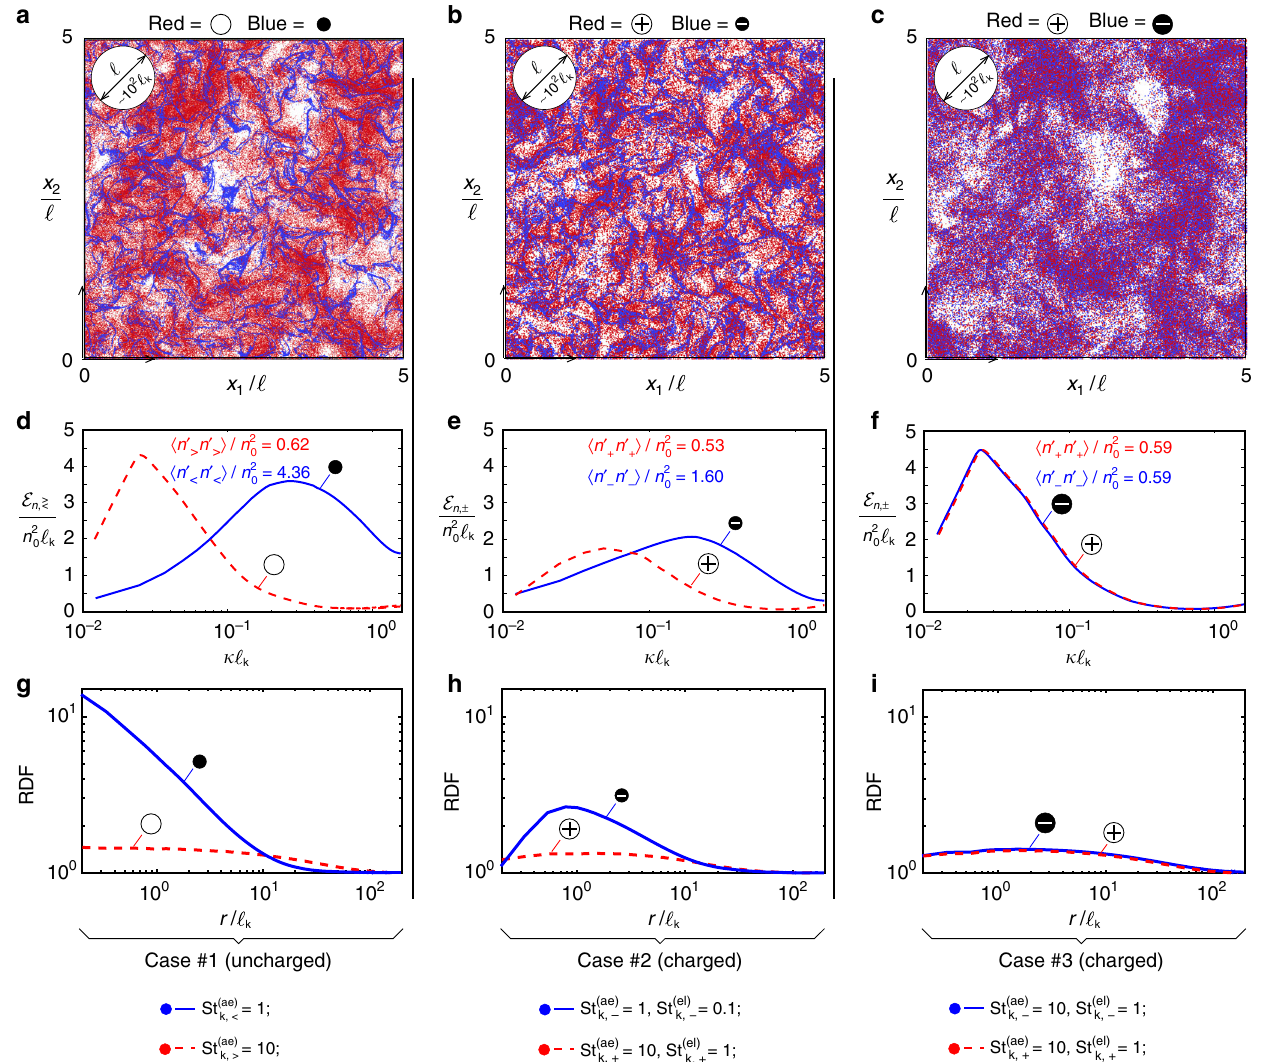
Fig. 2 Electric effects on the spatial distribution of particles. a – c Instantaneous spatial distributions of particles contained in a constant- x 3 slice of thickness equal to the Kolmogorov length ‘ k . d – f Ensemble-averaged spectral energy E n of the concentration fl uctuations as a function of the wavenumber κ . g – i Ensemble-averaged radial distribution functions (RDFs) as a function of the radial separation distance r . The fi gure includes the uncharged case #1 ( a , d , g ), the charged case #2 (with negatively charged small particles being preferentially concentrated; b , e , h ), and the charged case #3 (with none of the two classes being preferentially concentrated; c , f , i ). The integral length ‘ and its equivalent size in Kolmogorov units (~100 ‘ k ) are provided for convenience in the left upper corner of a –